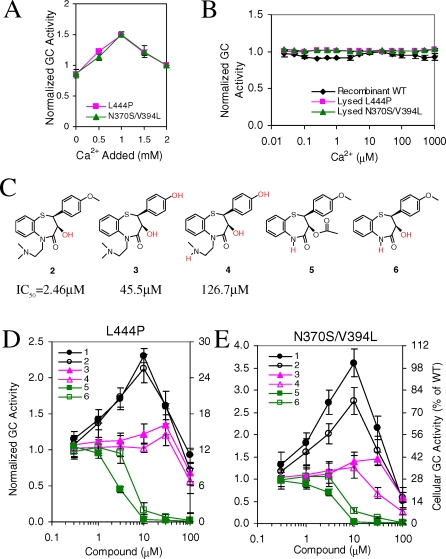
Intracellular Ca2+ Ion Concentration Influences GC Activity in L444P and N370S/V394L GC Fibroblasts(A) Variable Ca2+ ion cell culture media concentrations were applied to L444P GC cells for 10 d and to N370S/V394 GC cells for 7 d before using the lysed cell GC activity assay. The GC activity was normalized to that with 2 mM Ca2+ added in the media in both cases.(B) L444P and N370S/V394L GC cells were lysed and an equal amount of total cell protein was incubated with Ca2+ ions and their GC activities were evaluated using the lysed cell GC activity assay. Cerezyme, a recombinant WT GC enzyme, was also tested for its activity after Ca2+ treatment.(C) Chemical structure of diltiazem analogs (compounds 2–6; distinct substructures relative to compound 1 are shown in red) with their reported Ca2+ channel blocker IC50 values [44].(D) The influence of Ca2+ ion channel blockers of varying potency on L444P GC activity. L444P GC cells were incubated with compounds 1–6 for 7 d before using the intact cell GC activity assay to evaluate lysosomal GC activity.(E) The influence of Ca2+ ion channel blockers of varying potency on N370S/V394L GC activity. N370S/V394L GC cells were incubated with compounds 1–6 for 7 d before evaluating GC activity using the intact cell activity assay. For both (D) and (E), the GC activity of treated cells was normalized against that of untreated cells of the same type (left y-axis) and expressed as the percentage of WT GC activity (right y-axis).